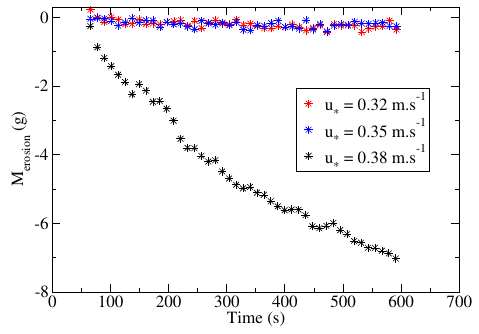
Figure 2. Temporal evolution of the mass of a dry sample in course of time for di ff erent friction speeds: For the two lowest friction speed, the erosion rate is constant during the experiment while for the highest friction speed the erosion rate is decreasing in course of